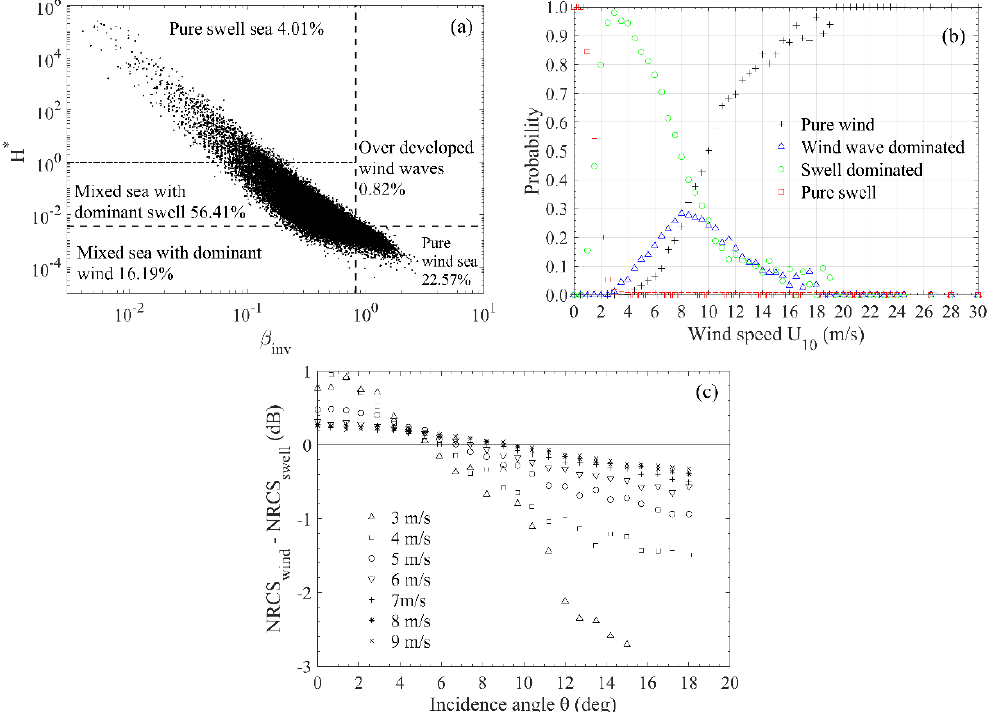
Figure 14. ( a ) Distribution of the satellite/buoy data in different wave conditions. ( b ) Probability of the data being in pure wind seas (black pluses), wind wave dominant seas (blue triangles), swell dominant seas (green circles), and pure swell seas (red squares) with respect to wind speed. ( c ) Magnitude of the difference of NRCS between the wind wave seas and the swell seas as a function of incidence angle at different wind speeds.